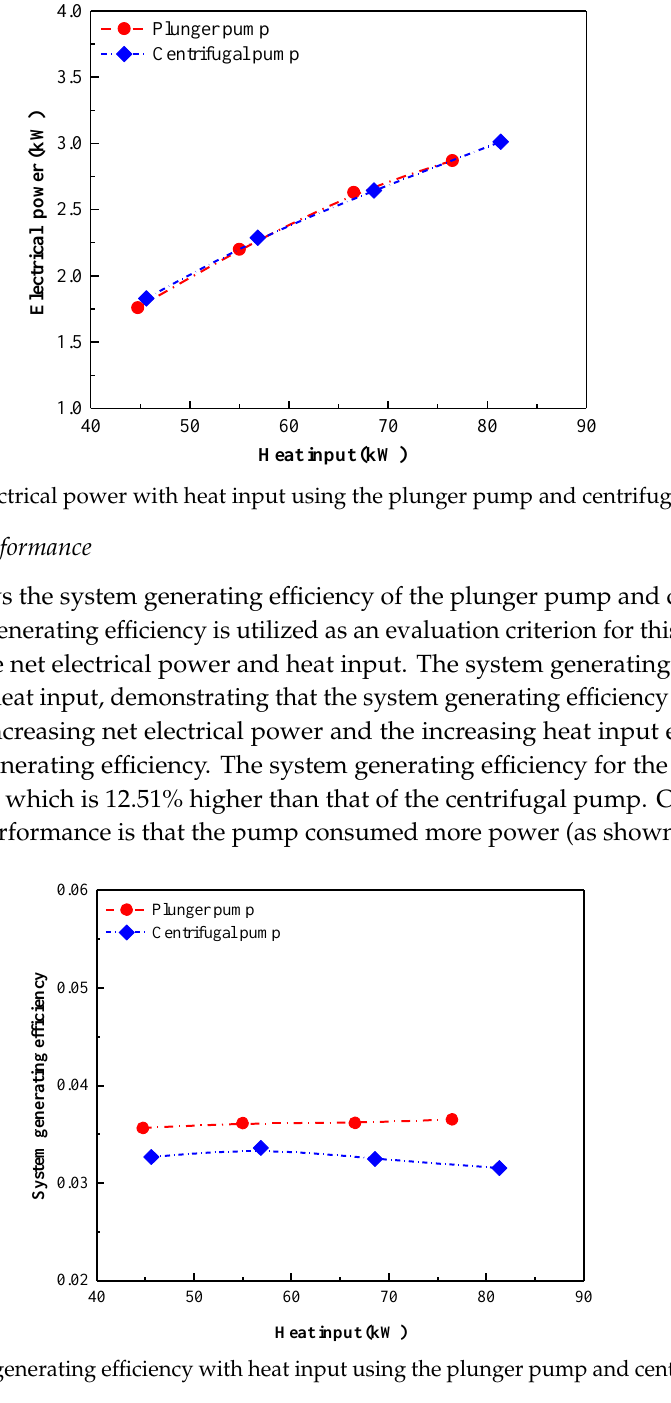
Figure 13. Electrical power with heat input using the plunger pump and centrifugal pump.